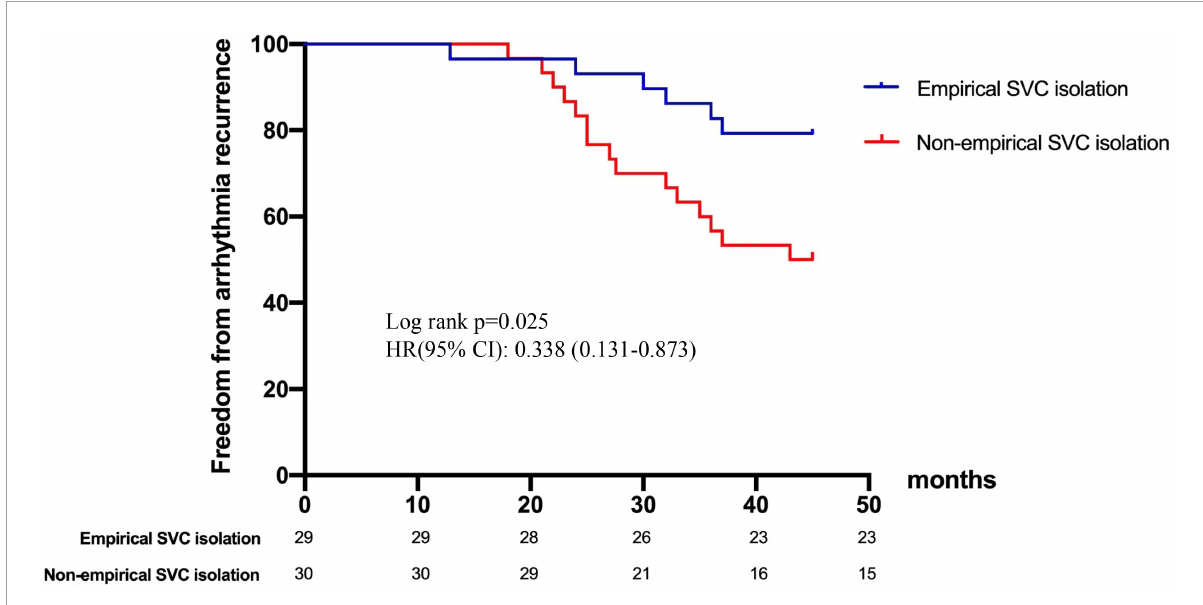
FIGURE4 Freedom from arrhythmia recurrence after repeat ablation procedure. Kaplan-Meier curve demonstrates significant difference in recurrence between empirical and non-empirical SVC isolation groups. SVC, superior vena cava.